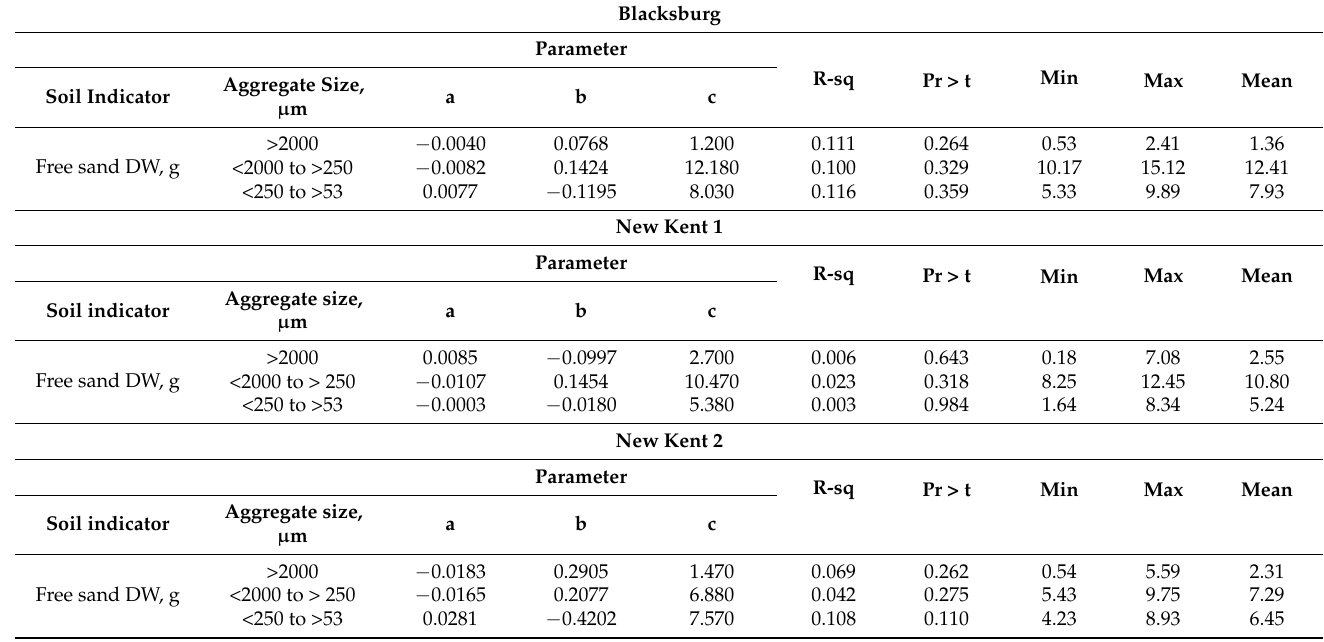
Table 6. Quadratic regression parameters, R square coefficient of determination, p -value, minimum (min), maximum (max) and mean response values for water aggregate stability measured as the free-sand dry weight (DW, in g) per each aggregate size (in µ m) for the 0 to 5 cm depth in 2017 in Blacksburg and New Kent (NK1 and NK2),